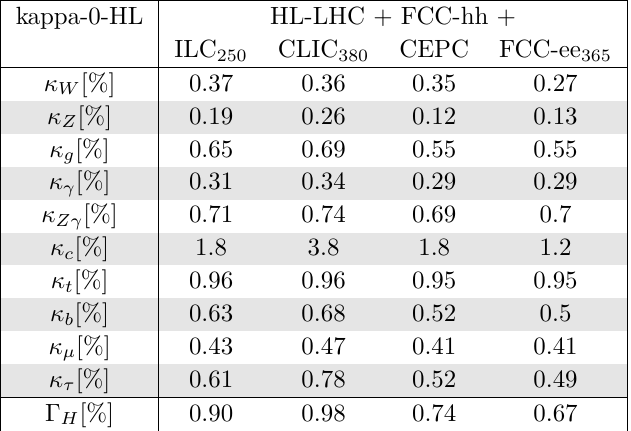
(cid:0) colliders